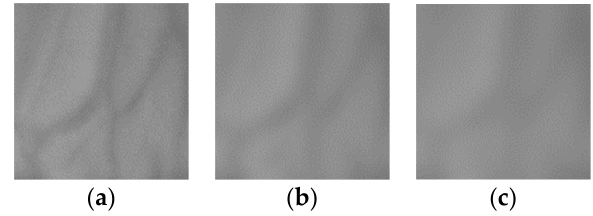
Figure 3. Dorsal hand vein image from 850 nm with different TPAVs after filtering. ( a ) TPAV = 15.3242 from the original ROI; ( b ) TPAV = 6.7584 with δ = 1.8; ( c ) TPAV = 2.7206 with δ = 2.6.